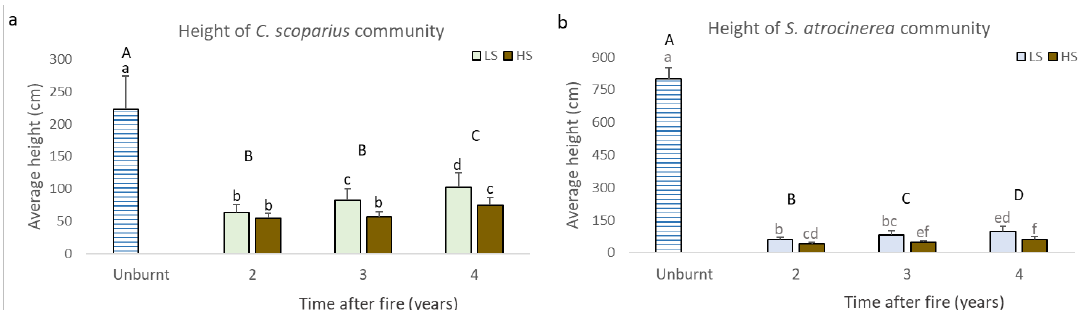
Figure 3. ( a , b ): The average height reached in unburnt areas and burned areas 2, 3, and 4 years after fire with di ff erent fire severity level in the C. scoparius and S. atrocinerea communities. a: height of C. scoparius community, b: height of S. atrocinerea community, HS: high severity, LS: low